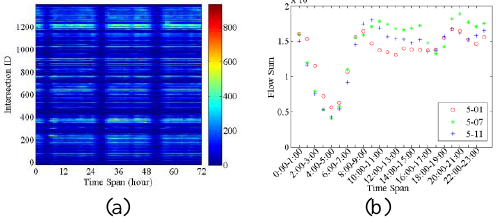
Figure 1. Traffic flow of intersections in each period